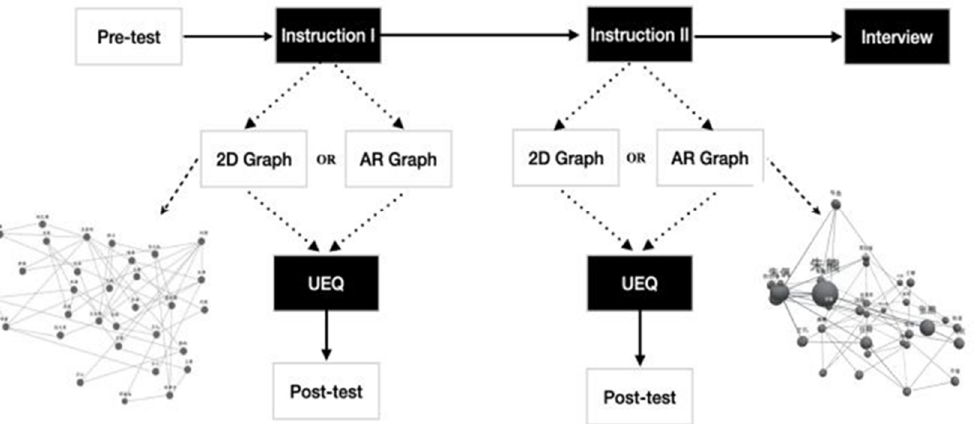
Figure 5. Experiment procedure (the text on top of the nodes are the Chinese names of the paint- ers).